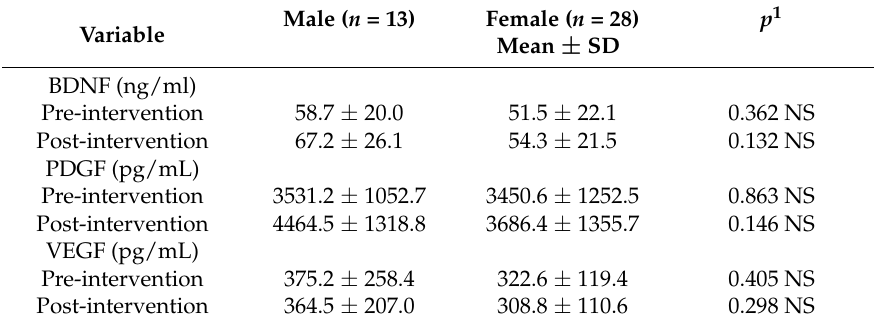
Table 4. The effects of a 20-min gardening activity program on brain nerve factor levels of senior individuals by